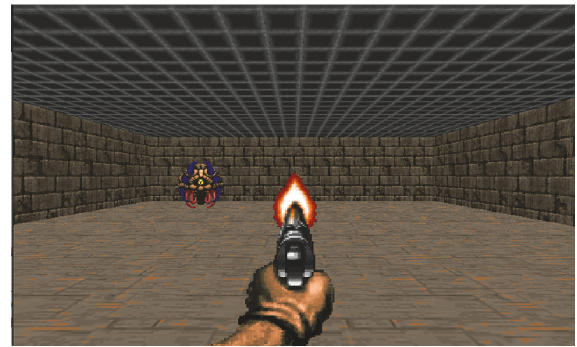
Figure 2: A rectangular chamber as a basic